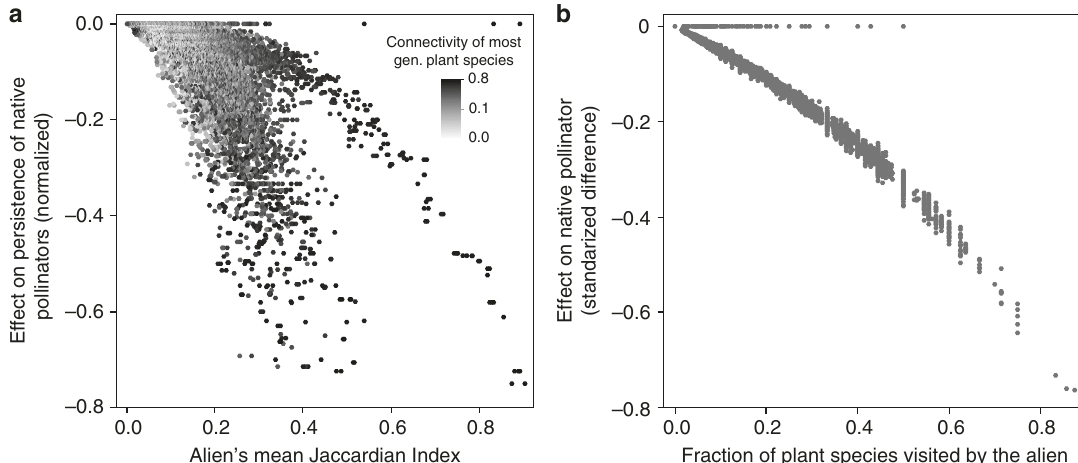
Fig. 2 Top factors determining the effect of alien ef fi cient foragers ( n = 21,600) on the persistence and density of native pollinators. In a , the alien ’ s mean Jaccardian index (i.e., diet overlap with native pollinators; x axis) and the connectivity of the most-generalist plant species (i.e., fraction of total native links connected to the most-generalist plant species; grayscale normalized as percentile) contributed 62% and 13%, respectively, to the CART model ( fi ve- folded R 2 = 0.89, see Supplementary Table 2) predicting the alien effect on native pollinator persistence, and were also highly signi fi cant factors in generalized linear models (Table 3). In b , the fraction of native plant species visited by the alien contributed 99% to the CART model ( fi ve-folded R 2 = 0.99, see Supplementary Table 2) predicting the alien effect on native pollinator density, and was also a signi fi cant factor in the generalized linear model (Table 3). Effects were calculated as the normalized difference of native persistence and density after and before the alien introduction. Zero and close-to- zero effects correspond to unsuccessful (1%) and naturalized (2%) ef fi cient foragers. All effects are negative or zero Fig. 3 Top factors determining the effect of alien ef fi cient foragers at high pollinators ’ mortality rates ( n = 10,800) on the density of native plants. The alien density ( x axis) and the fraction of native pollinator species that are specialist (i.e., one link; grayscale normalized as percentile) explained 60% and 19% of the variance in plant density, respectively in CART models ( fi ve- folded R 2 = 0.82, see Supplementary Table 3). Invasive pollinators did not cause any plant extinction and their effect on plant density was negligible for low pollinators ’ mortality ef fi ciency, diet overlap with native pollinators, fraction of plant species visited by the alien pollinator, connectivity of the most- generalist plant in the host community, and fraction of native pollinators with only one interaction. Such focus informs trait- based prediction in ecology 38 by suggesting that explanations based on species ’ traits alone may be limited. In particular, our results show that traits of alien species (foraging ef fi ciency) predict the invasion success of alien pollinators, while traits of networks are needed to predict the impact of invading pollinators on native species. Research that continues this trend of incorporating bio- logical processes such as consumer – resource interactions,